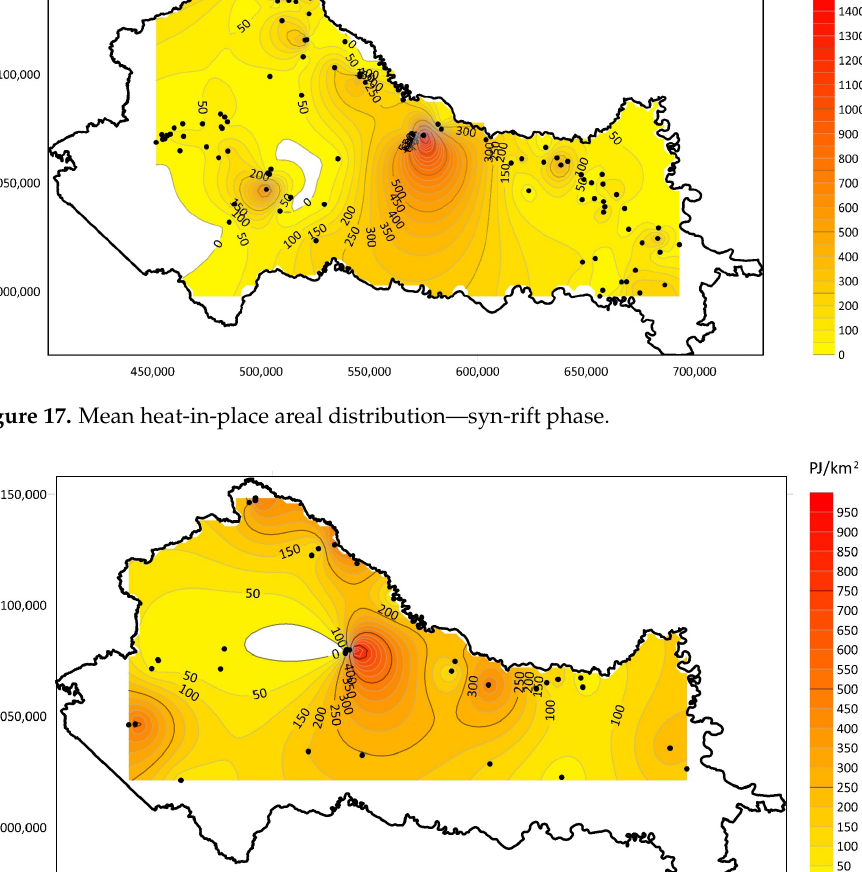
Table 4. Input parameters for model.